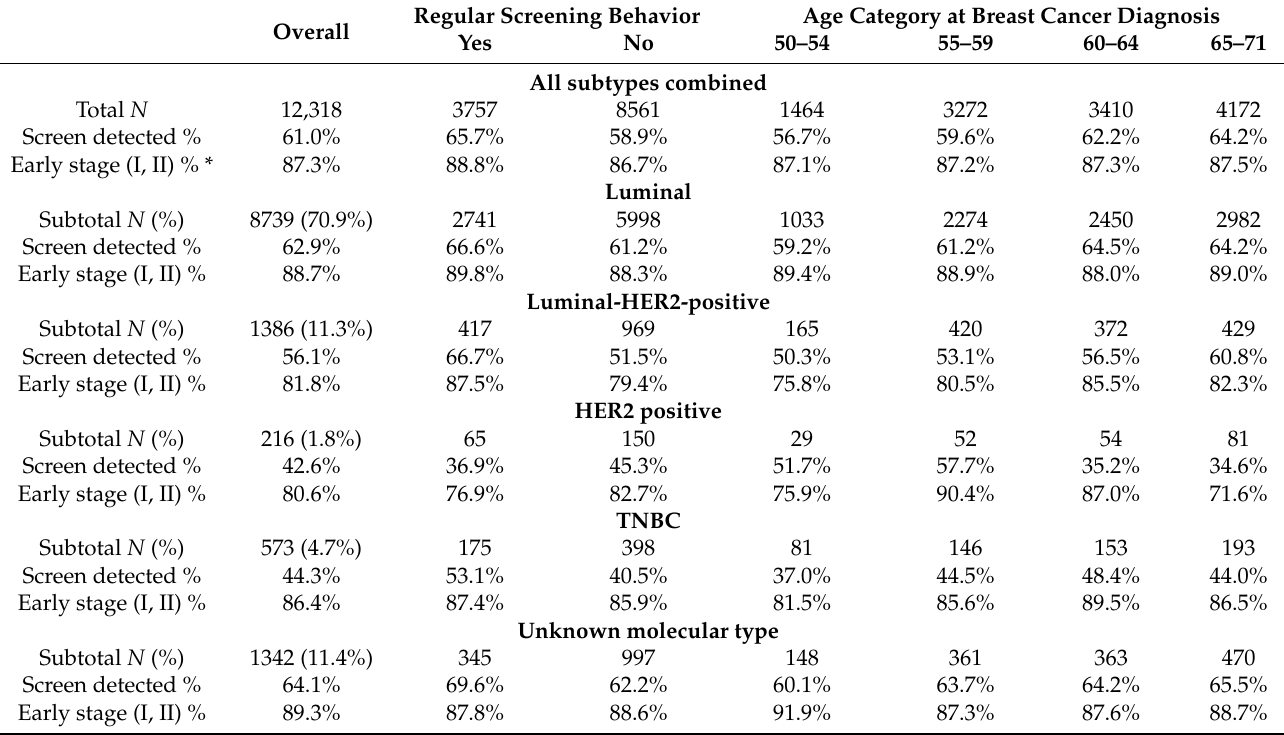
Table 1. The number, % screen detected, % early stage of diagnosed breast cancers, in total and per molecular subtype, overall, and stratified by regular screenings behavior and age category ( n =